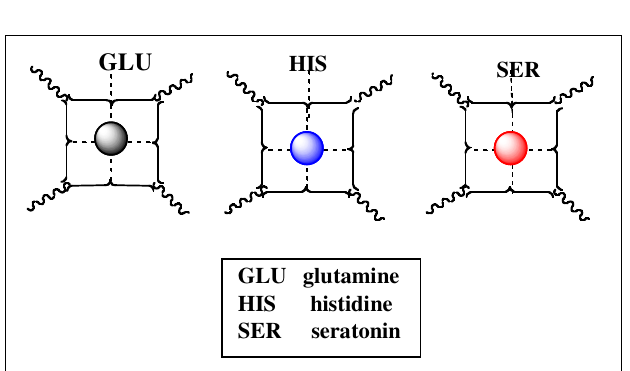
FIGURE 6 | Icons of cuinfo tagged with various neurotransmitters, as ternary